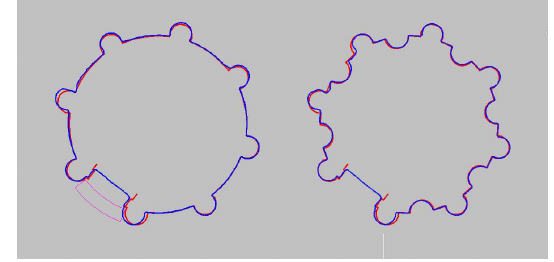
Figure 7: Auteri Chapel reconstruction error evaluation on horizontal profiles: yellow 123D Catch model, red GCP